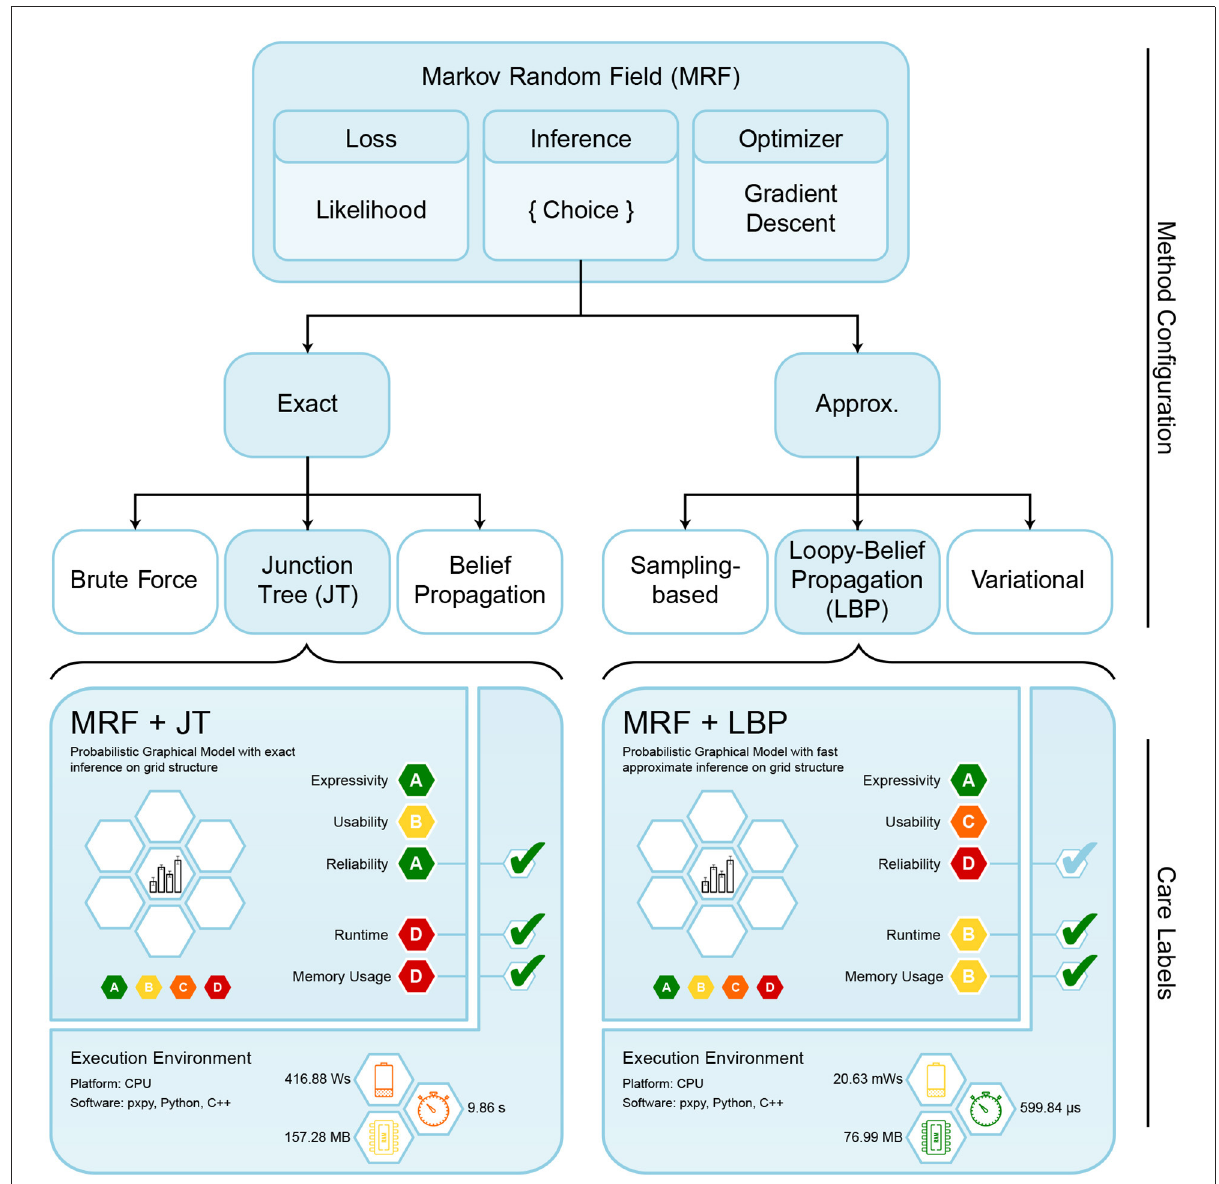
FIGURE5 Overview of configurable components for MRFs. Each instanced model requires choosing the loss, an optimizer and an inference algorithm. For our experiments we chose likelihood as loss function, gradient descent for optimization, and evaluated two different inference algorithms. The respectively instantiated care labels are shown below, with resulting theoretical and practical